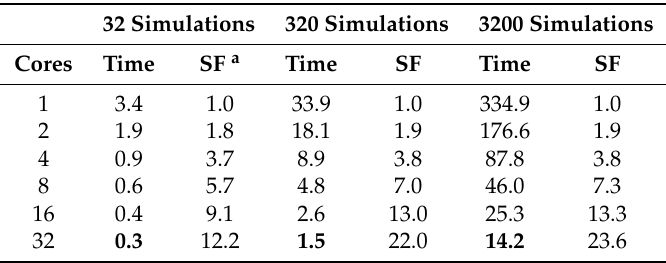
Table 7. Runtime in minutes and “speed-up” factor as a function of number of cores used in simulations. 32 Simulations 320 Simulations 3200 Simulations Cores Time SF a Time SF Time